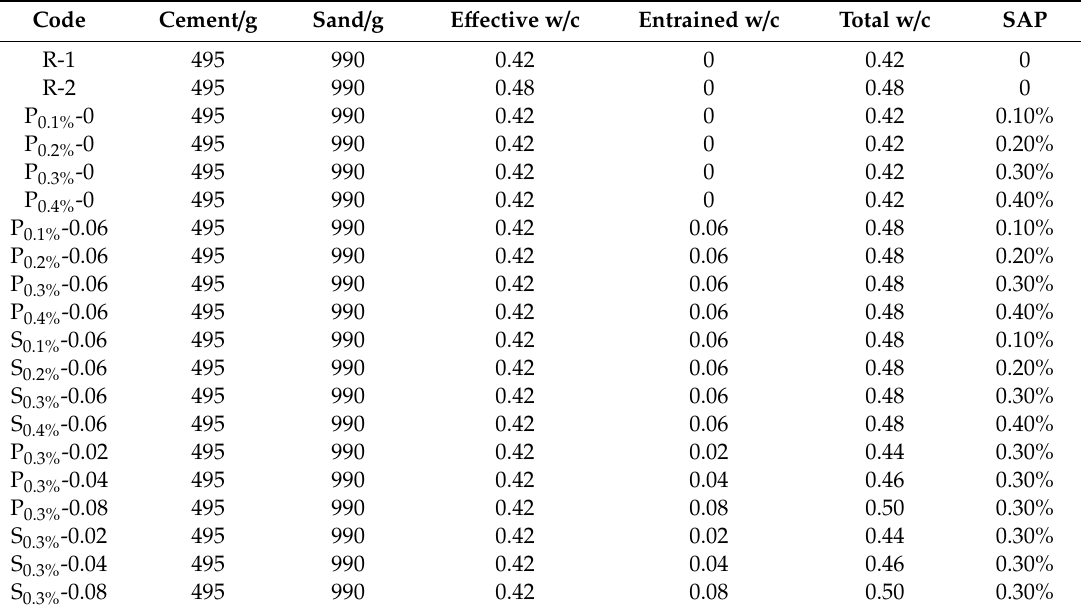
Table 2. Design of SAP-modified cement